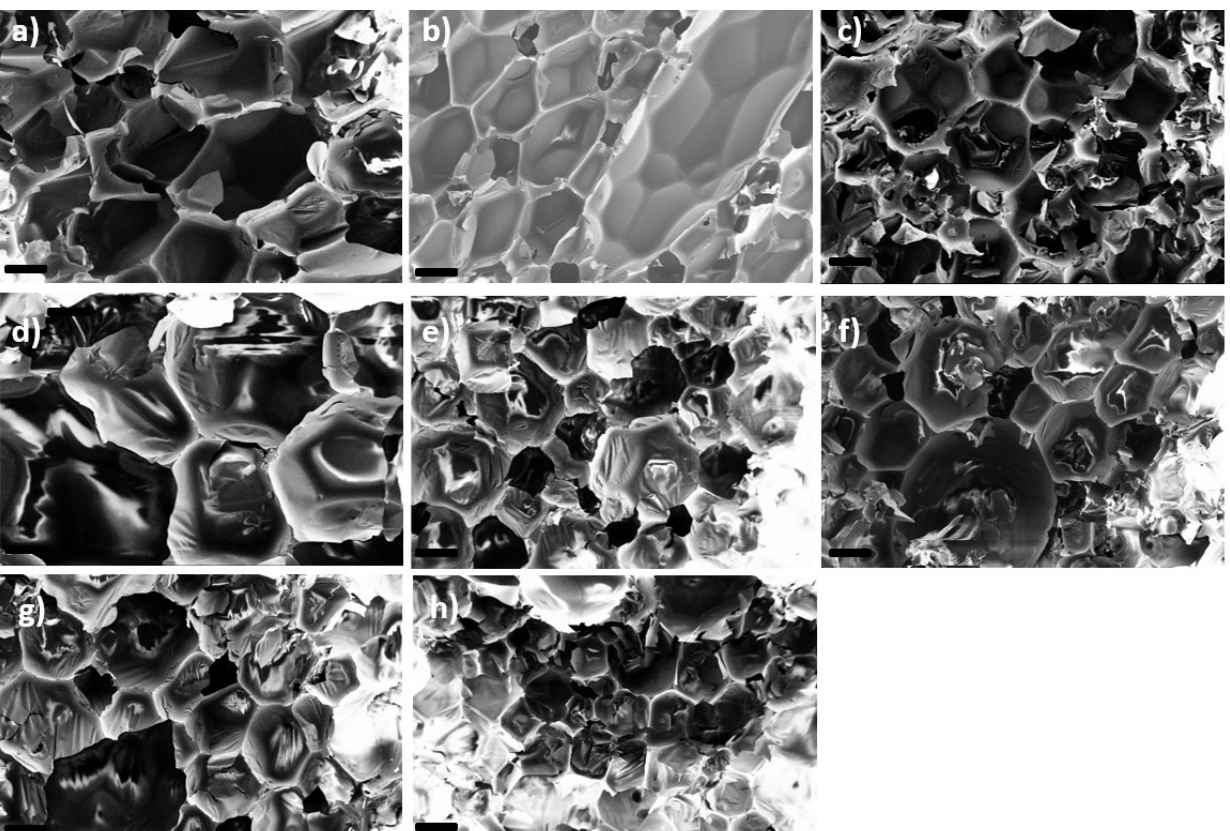
Figure 2. SEM images of selected PIR foams with closed-cell and open-cell morphology (scale bar: 200 μ m): ( a ) PIR-0 (closed-cell); ( b ) TPP/TEP-1.0 (closed-cell); ( c ) EA-BPPO/TEP-1.0 (closed-cell); ( d ) FA-BPPO/TEP-1.0 (open-cell); ( e ) FU-BPPO/TEP-1.0 (open-cell); ( f ) FU-DOPO/TEP-1.0 (closed-cell); ( g ) TA-BPPO/TEP-1.0 (open-cell); and ( h ) TA-DOPO/TEP-1.0 (open-cell).